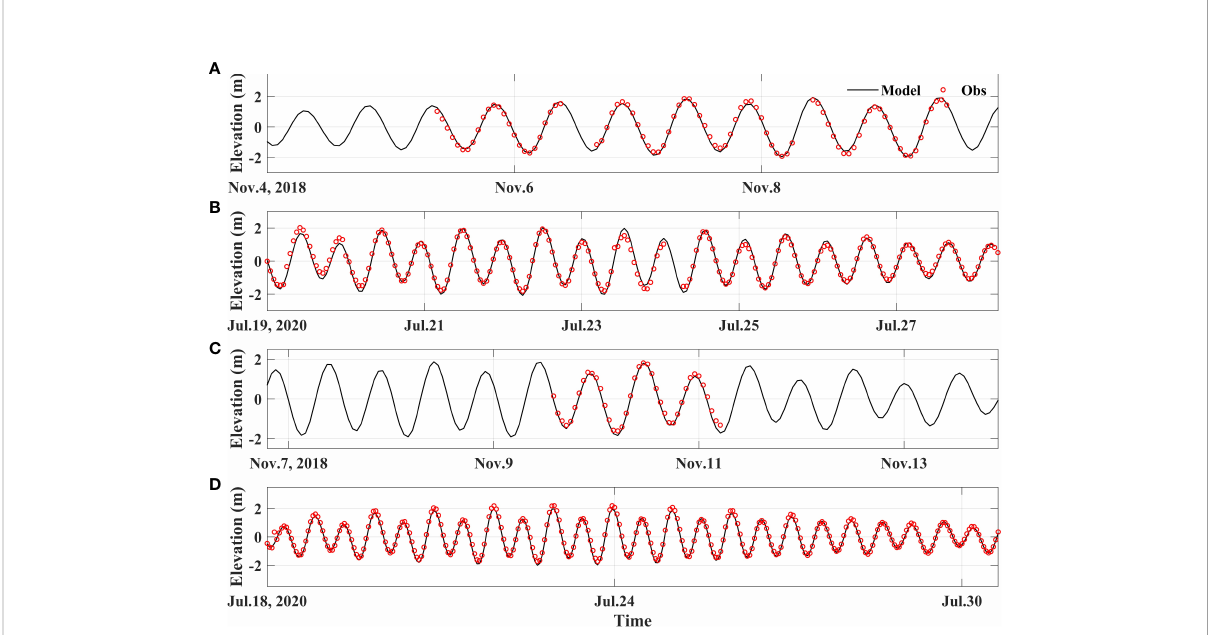
FIGURE 5 Model-data comparisons of tidal elevations at (A) S4 outside the farm, north of farm, (B) S5 outside the farm, south of Gouqi Island, (C) S6 north of Shengshan Island and (D) LvHua Tide Station (30°49 ′ N, 122°36 ′